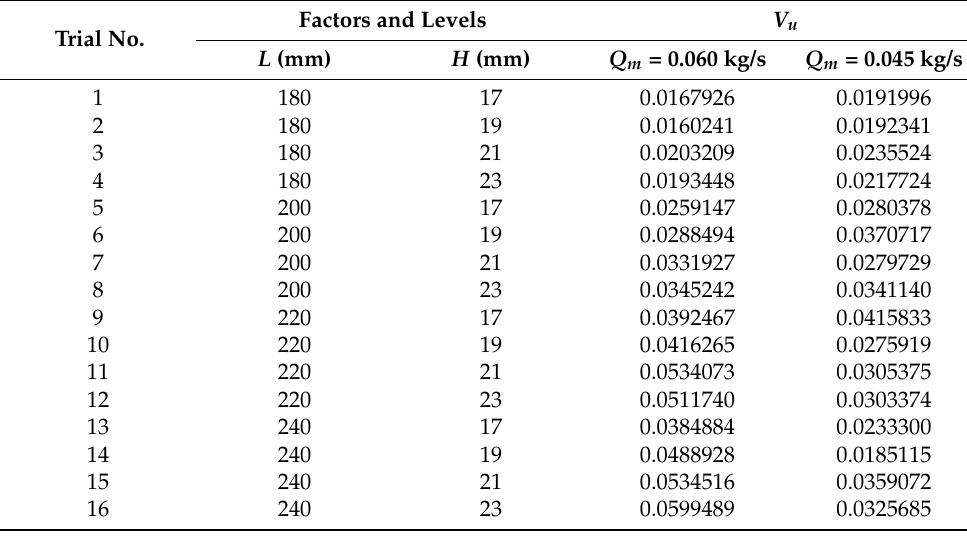
Table 4. Uniformity of velocity